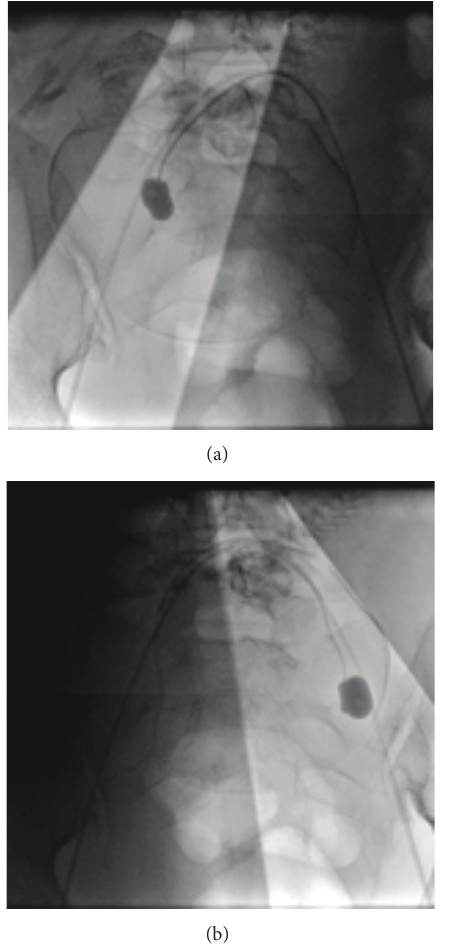
Figure 3: A series of images acquired during the placement of the catheters using shielding. (a) right internal iliac artery and (b) left internal iliac